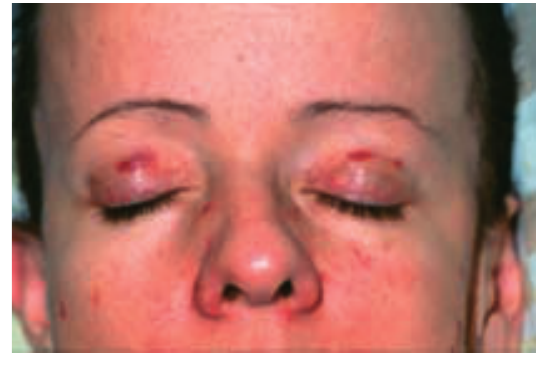
Macroglossia in amyloidosis. The tongue is frequently rimmed by the indentation of